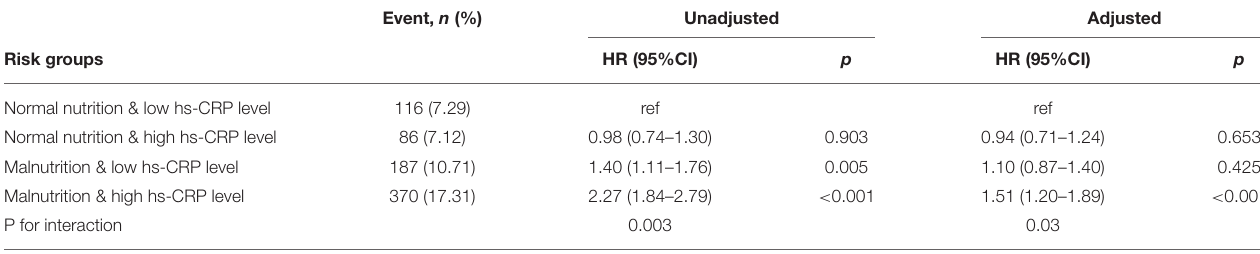
TABLE 3 | HR of all-cause mortality by inflammation combined with nutritional